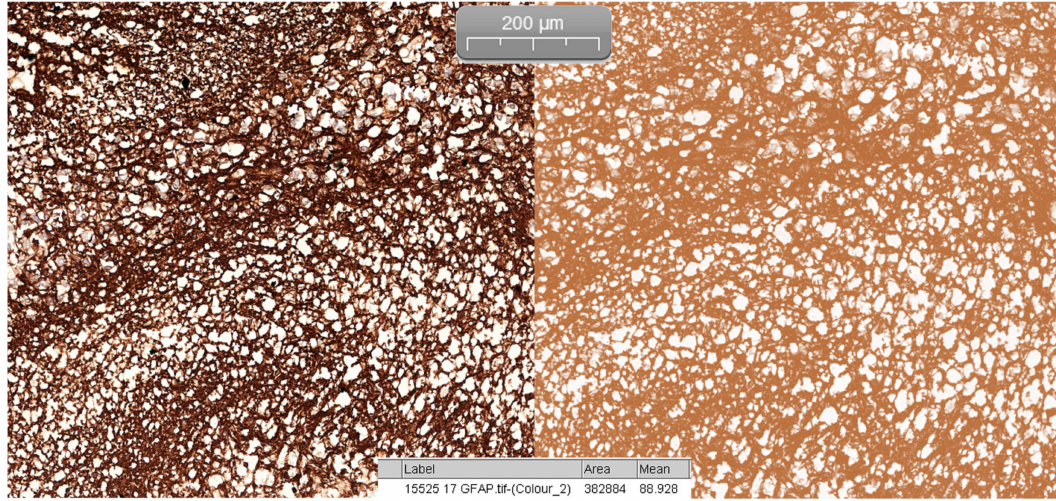
Figure 4. Color deconvolution of H DAB and calculation of mean grey value using ImageJ